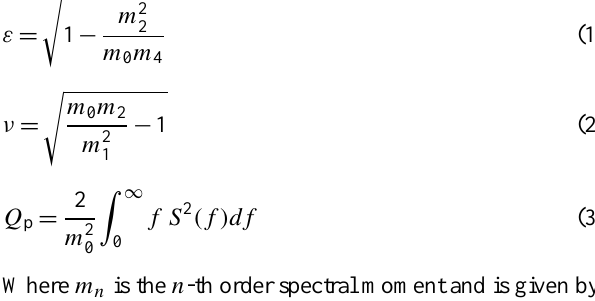
17–24 March 1986 was studied by Rao and Baba